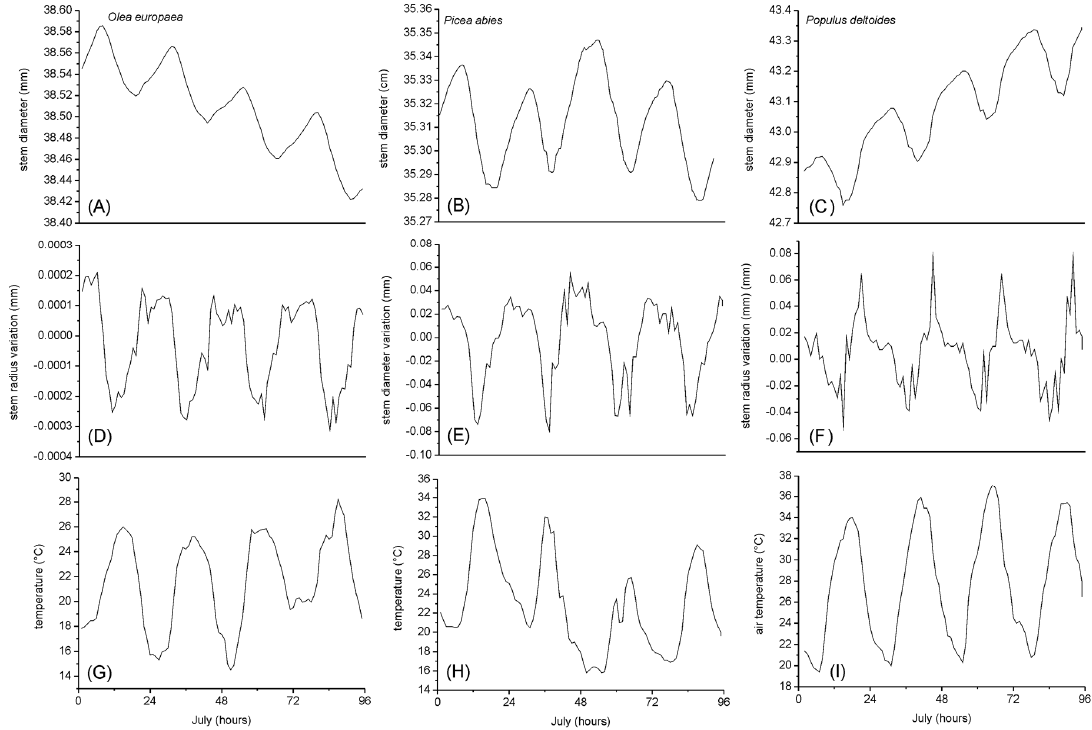
Figure 3. Raw data of stem diameter ( A – C ), stem diameter variation ( D – F ) in O. europaea , P. abies , P. deltoides , and air temperature ( G – I ) in field